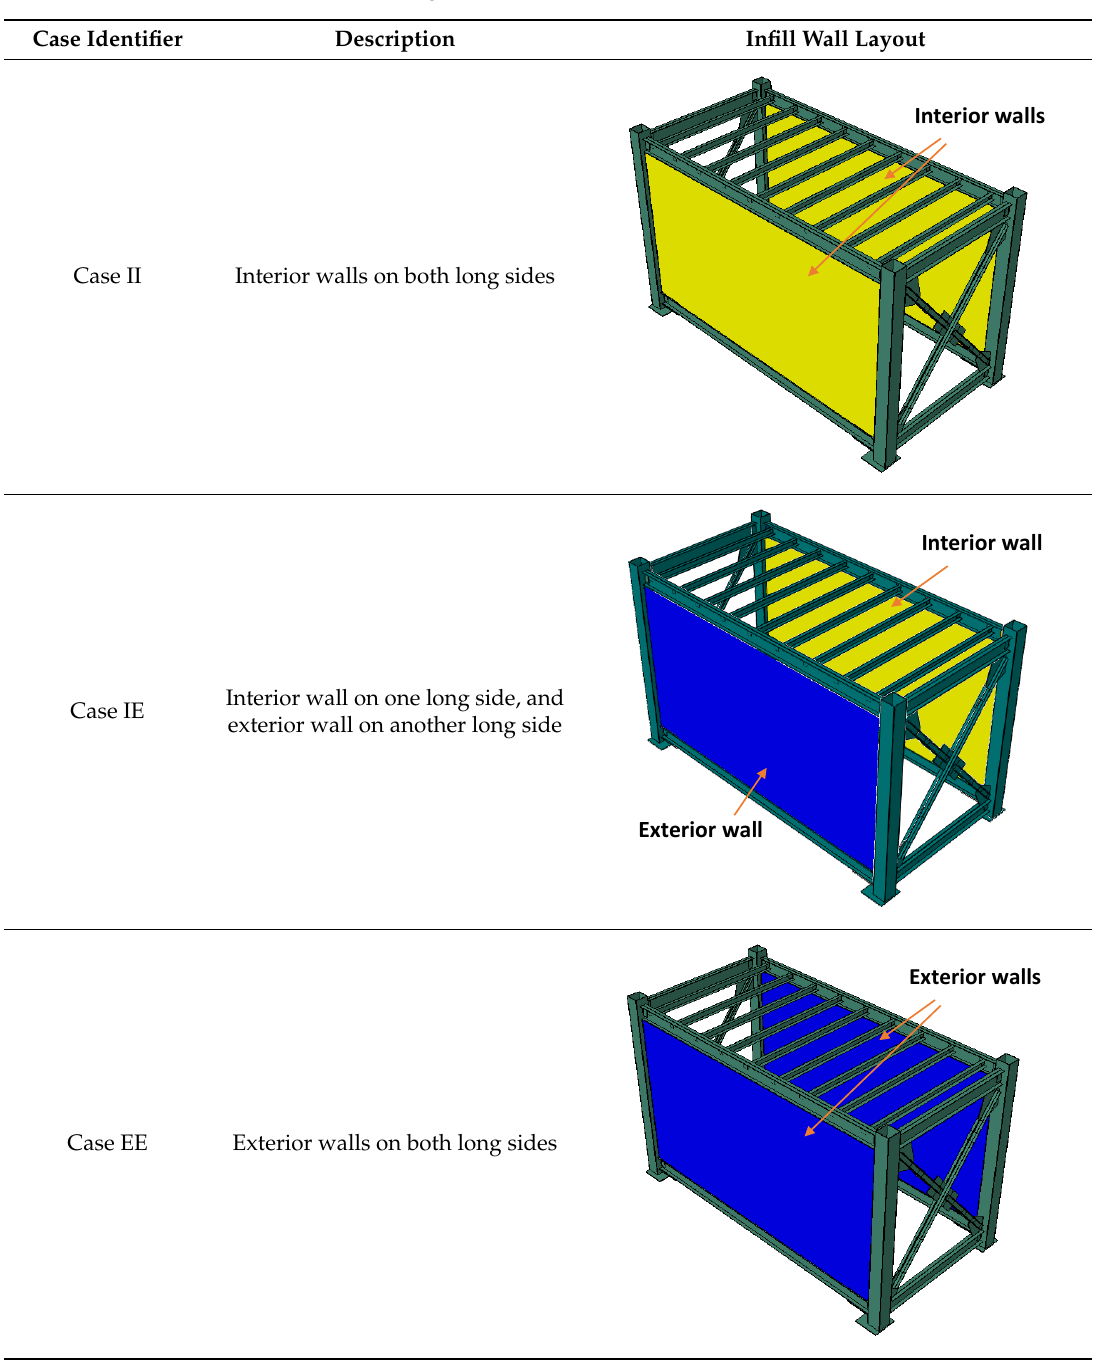
Table 1. Different configurations of infill walls studied in this research.